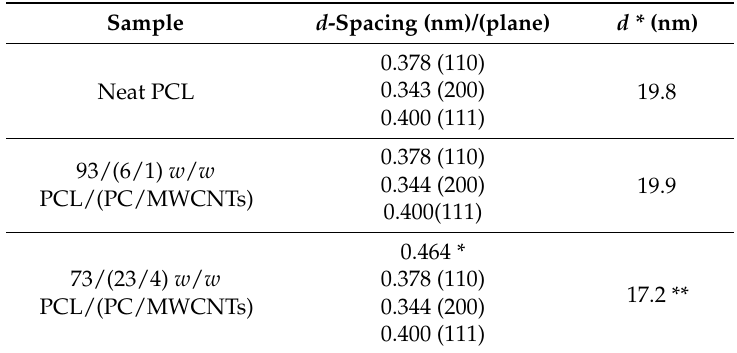
Table 2. Calculated values of d -spacing (from WAXS (Wide Angle X-ray Scattering) experiments) and long period ( d* , obtained from SAXS (Small Angle X-ray Scattering) experiments) for the neat PCL and its